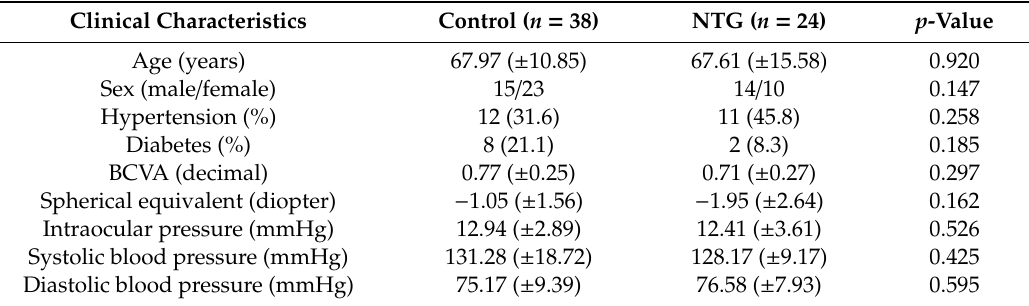
BCVA: best corrected visual acuity.